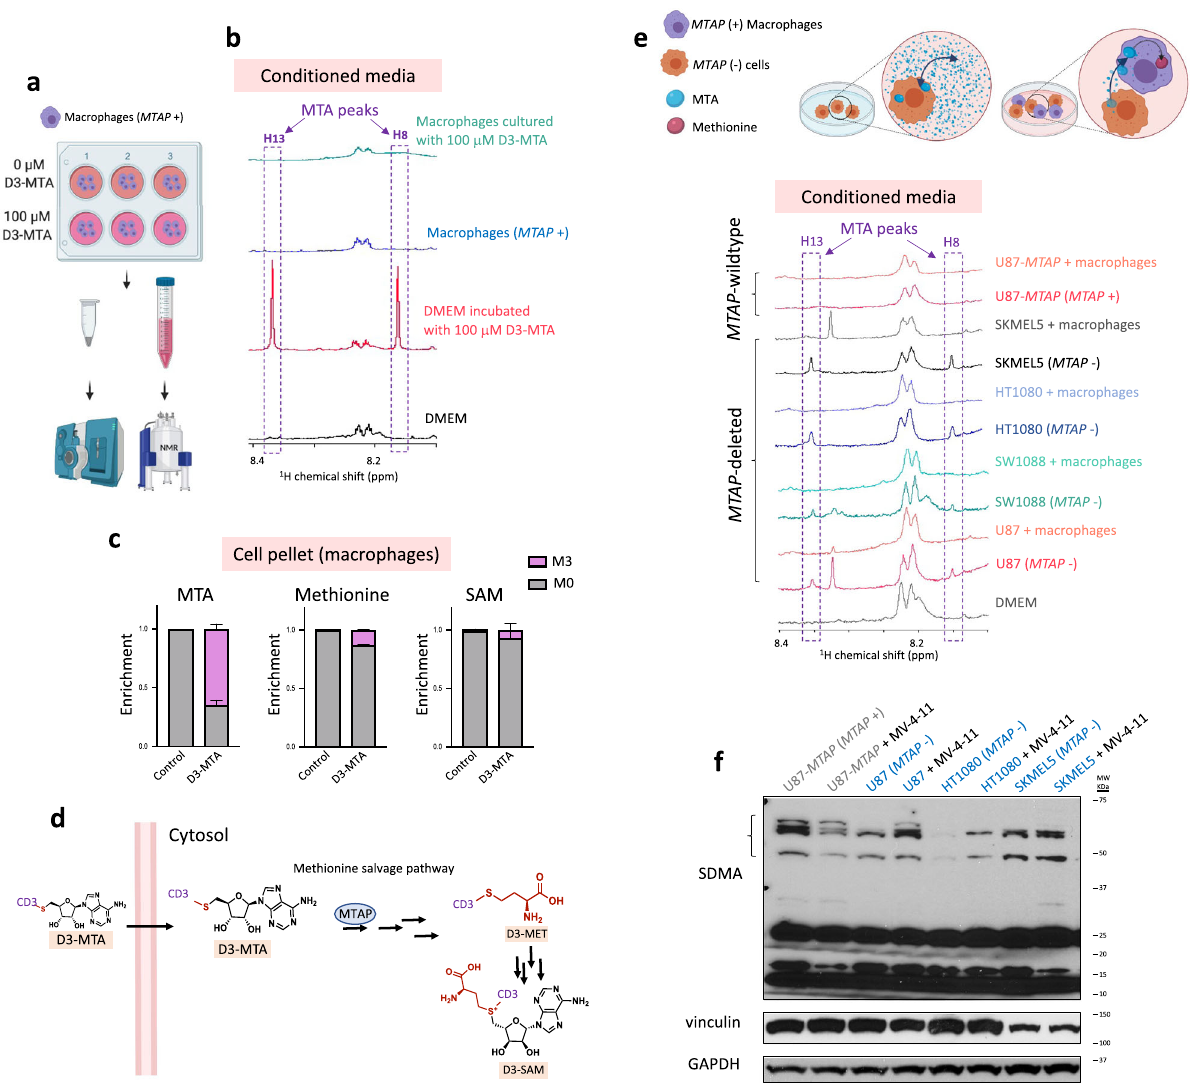
Fig. 4 Exogenous MTA is consumed by MTAP -intact cells through the methionine salvage pathway. a MTAP -WT macrophages (RAW-264.7) were cultured with 100 µ M methyl tri-deuterated-MTA (D3-MTA). Cells and conditioned media were extracted and prepared for LC-MS and NMR measurements, respectively. b Exogenous D3-MTA rapidly disappears from the media in cultures of macrophages, as the deuterium label (Mass + 3; M + 3) appears in intracellular methionine and SAM ( c ), consistent with MTAP -dependent metabolism by the methionine salvage pathway ( d ). Data in panel c are expressed as mean + SD, N = 3 biological replicates. e MTAP -deleted cancer cells accumulate MTA in conditioned media (detected by NMR) while secreted MTA is consumed by MTAP -intact macrophages, abrogating MTA accumulation in the extracellular environment. f Co-culture of MTAP -deleted cancer cell lines with MTAP -intact myeloid cells prevents loss of SDMA, indicating maintained PRMT5 activity, repeated once. MTAP -deleted and reconstituted glioma cells were co-cultured with myeloid leukemia cells (MV-4-11, a monomyelocytic suspension cell line). Before lysate preparation, suspended MV-4-11 myeloid cells were removed, and cancer cells were extensively washed. For each independent MTAP- deleted cell line, SDMA levels increased with myeloid co-culture, indicating restoration of PRMT5 Fig. 3c in that publication 9 ) in a substantial fraction of GBM tumors. Our study evaluated MTA in bulk GBM tumors, which are a heterogeneous mixture of cancer and stromal cells. One shortcoming of performing metabolomics and western blots on such tumors is that the measured signal (i.e., MTA levels and SDMA levels) derived from both cancer and stromal cells.